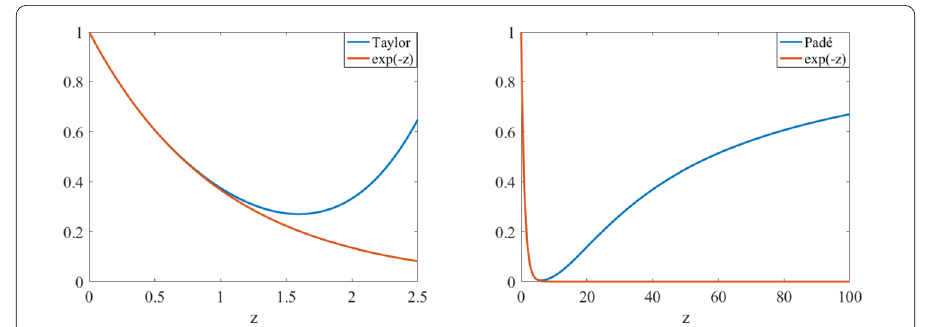
Figure 1 The behavior of the Taylor approximation with the real number field z ∈ [0,2.5] and Padé approximation with the real number field z ∈